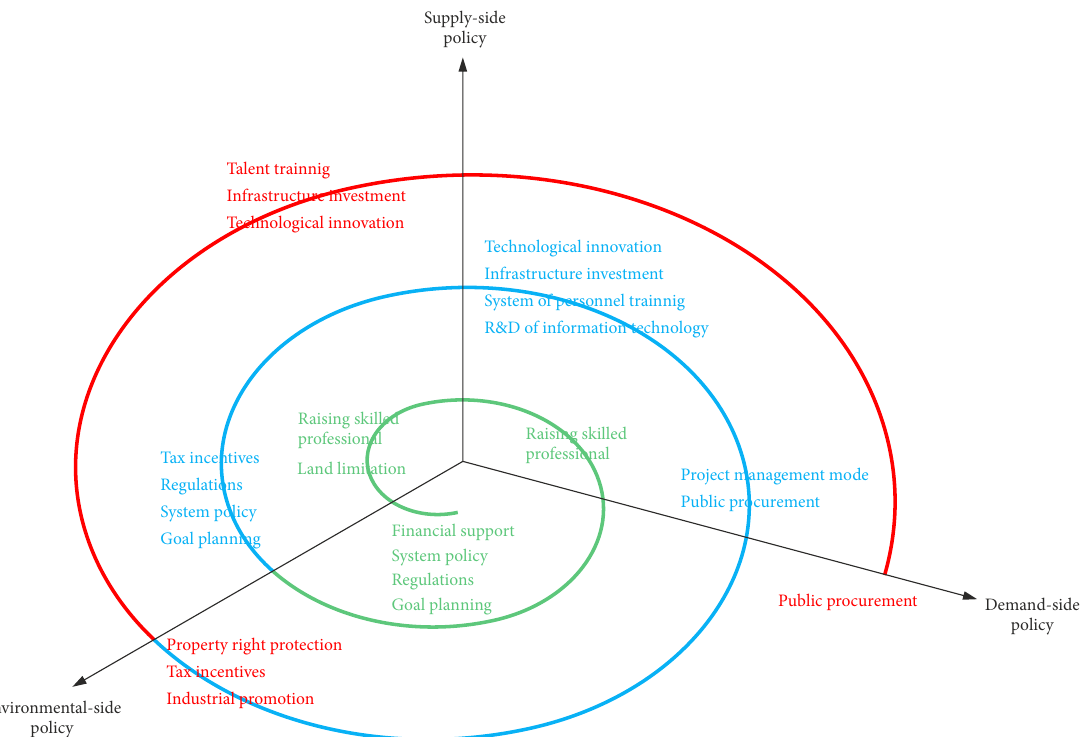
Figure 3. A dynamic policy